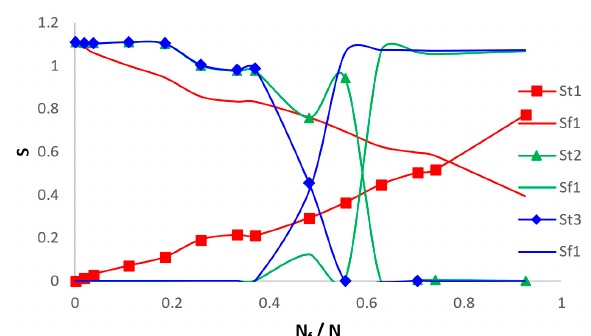
Figure 3. Sensitivity of the pore network with fracture density ( S t 1 and S f 1 are sensitivities when the fracture radius is 6 um, S t 2 and S f 2 are sensitivities when the fracture radius is 60 um, and S t 3 and S f 3 are sensitivities when the fracture radius is 90 um, respectively).